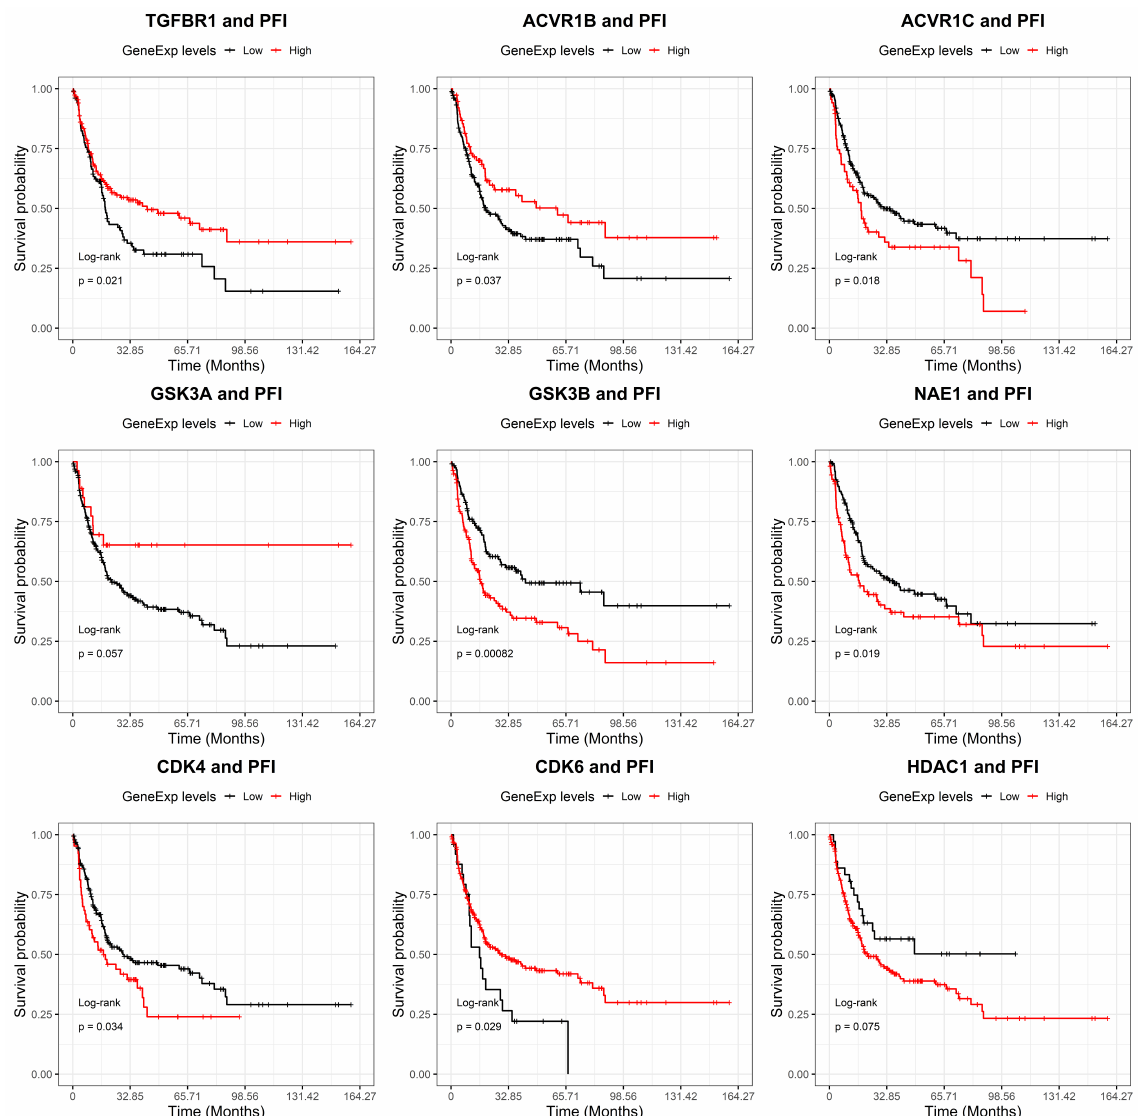
Figure 2. Progression-free interval (PFI) curves, based on mRNA expression levels of the nine drugs’ target genes in the TCGA Sarcoma dataset. High (red) and low (black) expression cohorts were divided through maximally selected rank statistics. The significance of survival differences was estimated by log-rank tests. Number of patients: TGFBR1: low 104, high 155; ACVR1B: low 182, high 77; ACVR1C: low 191, high 68; GSK3A: low 232, high 27; GSK3B: low 121, high 138; NAE1: low 149, high 110; CDK4: low 195, high 64; CDK6: low 25, high 234; HDAC1: low 36, high